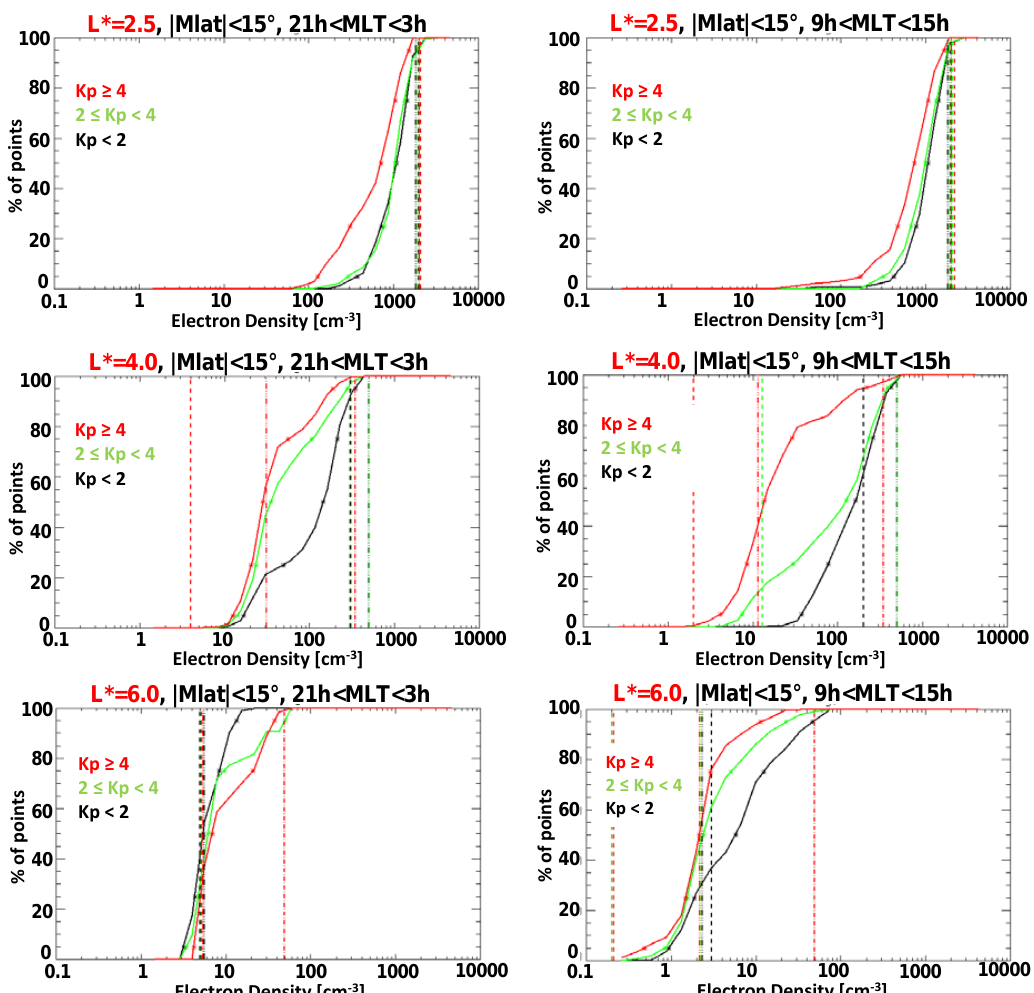
Figure 2. Electron plasma density (cm − 3 ) resulting from CRRES measurements versus percentage of cumulated points for three L ∗ values ( L ∗ = 2.5 on top, L ∗ = 4.0 in the middle and L ∗ = 6.0 at the bottom), for two MLT intervals (around midnight on the left and around noon on the right). On each plot, three magnetic activities are represented: quiet (in black), moderate (in green) and active (in red). Results from the GCPM , Sheeley and Carpenter models are also represented in dashed lines, dash-dot lines and dash-dot-dot-dot lines, respectively.